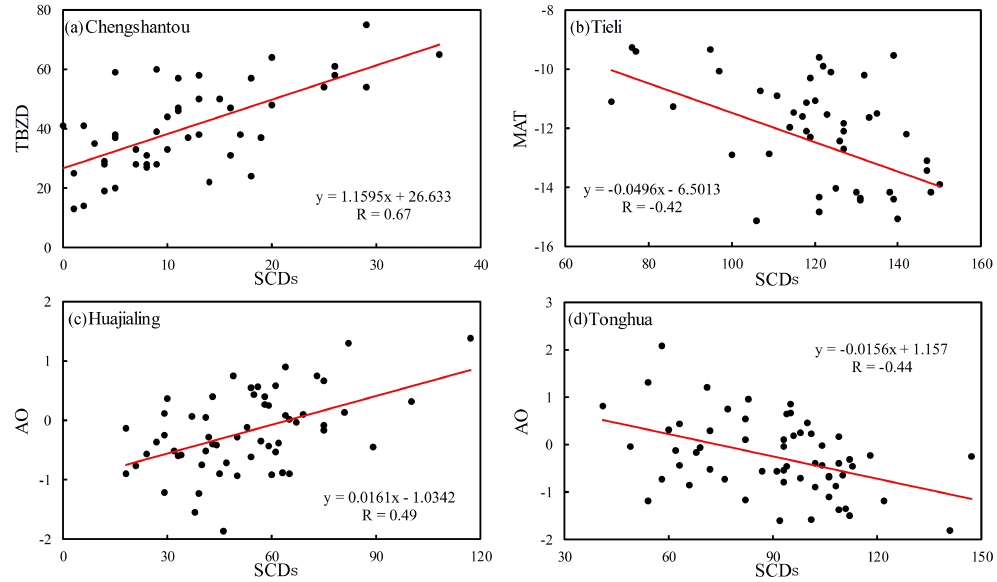
Figure 9. SCDs relationships with TBZD at Chengshantou (37 ◦ 24 (cid:48) N, 122 ◦ 41 (cid:48) E; 47.7m) (a) , MAT at Tieli (46 ◦ 59 (cid:48) N, 128 ◦ 01 (cid:48) E; 210.5m) (b) , and AO index at Huajialing (35 ◦ 23 (cid:48) N, 105 ◦ 00 (cid:48) E; 2450.6m) (c) and Tonghua (41 ◦ 41 (cid:48) N, 125 ◦ 54 (cid:48) E; 402.9m) (d)